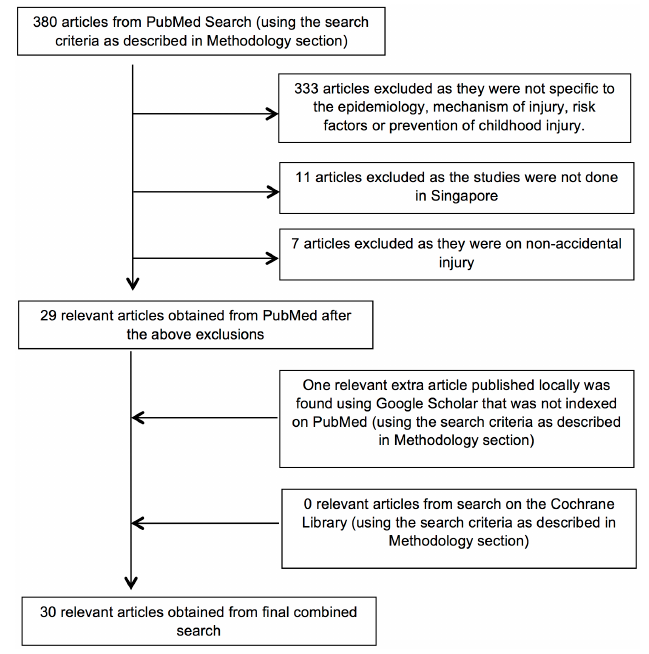
Figure 1. Details of the article selection process in the literature search.